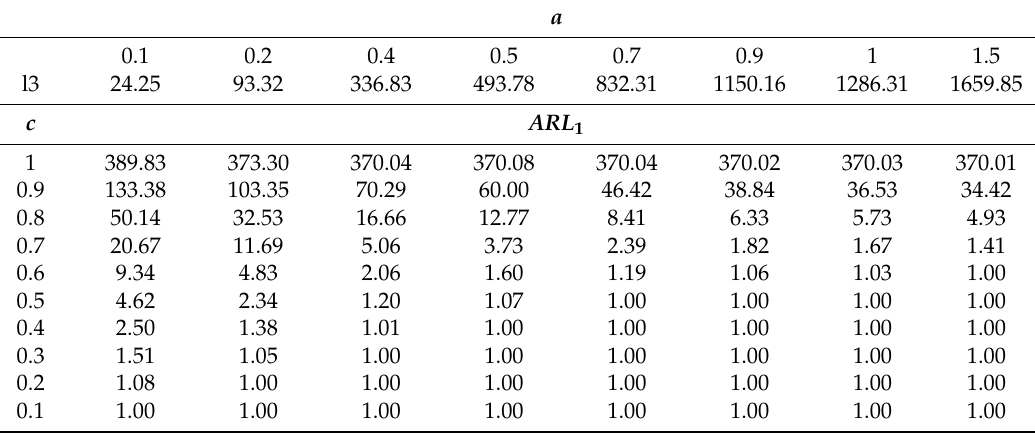
Table 7. The values of ARLs when r 0 = 370, β = 2, and µ 0 =